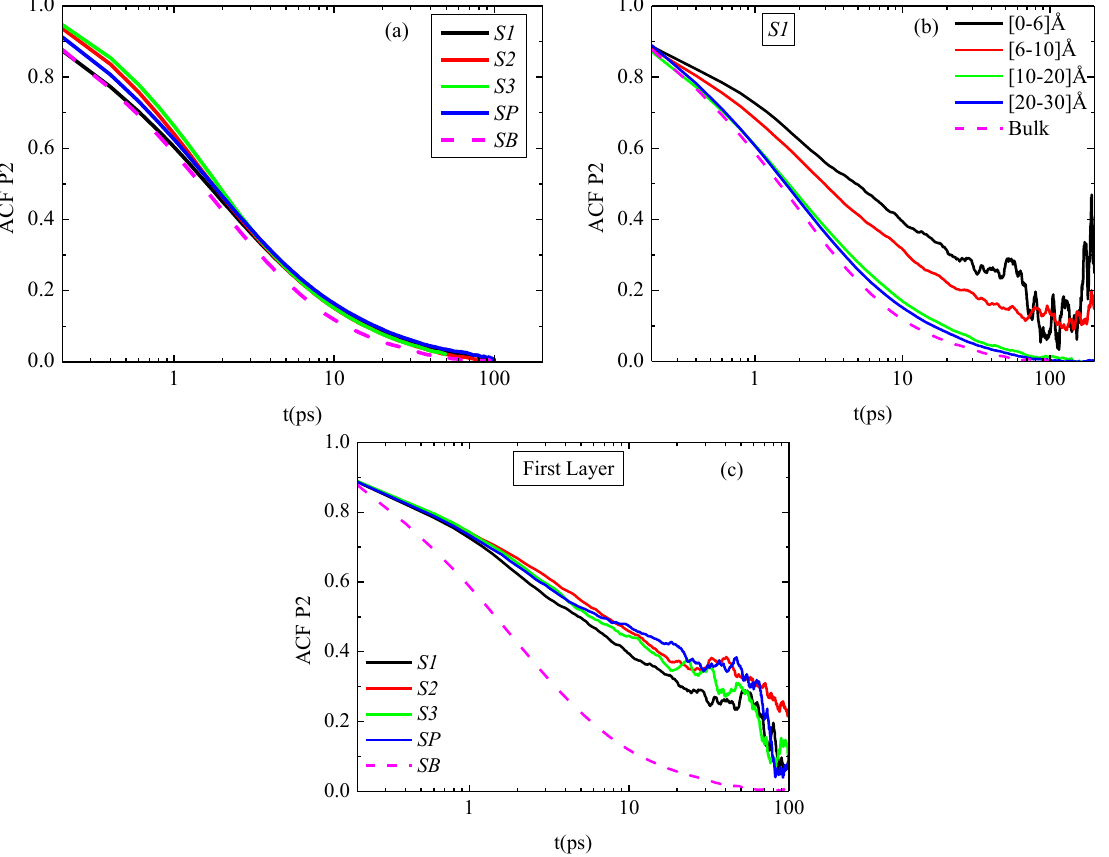
Figure 6. Time autocorrelation function (ACF) of bond order parameter P 2 ( t ) as a function of time for the characteristic vector v 1−3 of polyethylene for all systems. ( a ) Average P 2 ( t ) values are over the entire system; ( b ) P 2 ( t ) values for the S1 system, for various spherical shells; ( c ) P 2 ( t ) values for all systems in the first adsorption layer. In all cases the corresponding bulk system is presented as